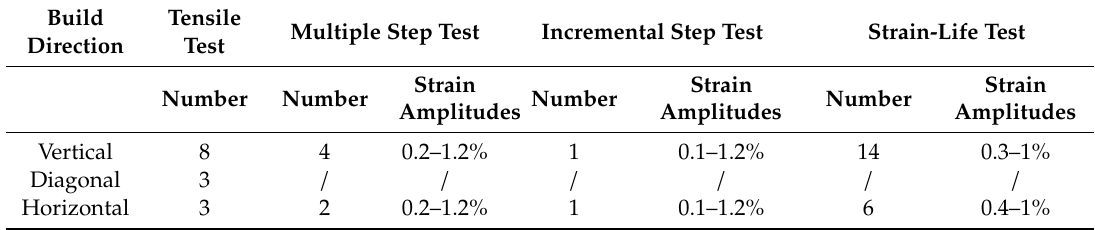
Table 2. Experimental program.